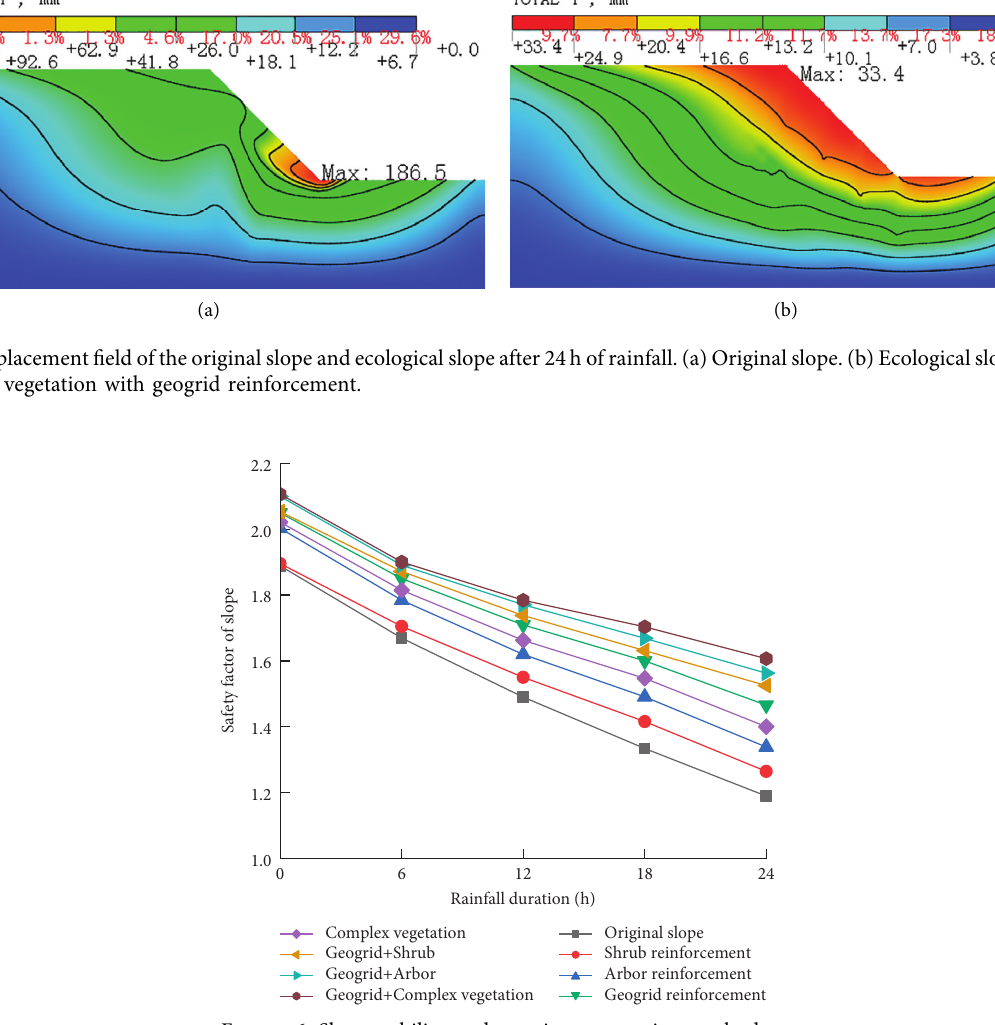
Figure 6: Slope stability under various protection